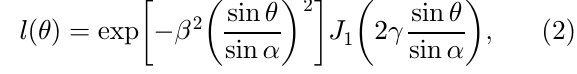
Table 1. Optimized parameters of binary